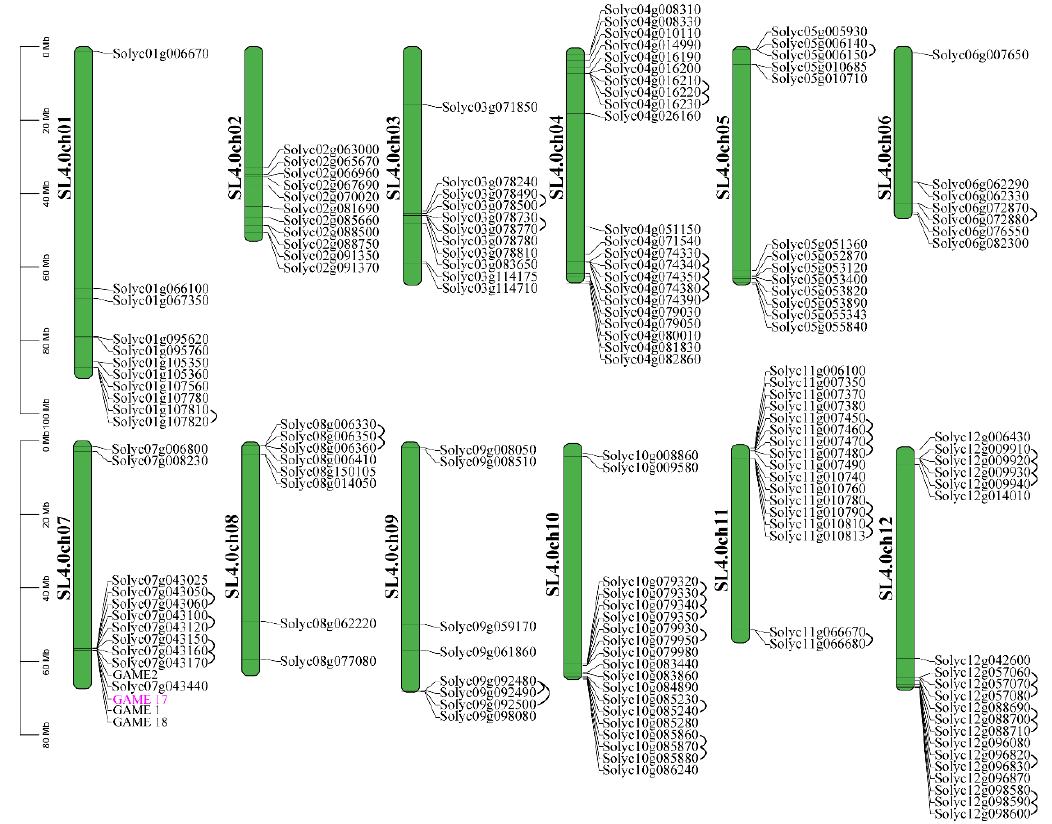
Figure 1. The distribution of SlUGT genes on the chromosomes in S. lycopersicum . The two chromo- some sizes are indicated by their relative length, and the genes marked by the curve in the figures are tandem-duplicated genes, the GAME 17 gene (Solyc07g043480) was marked by prink color.